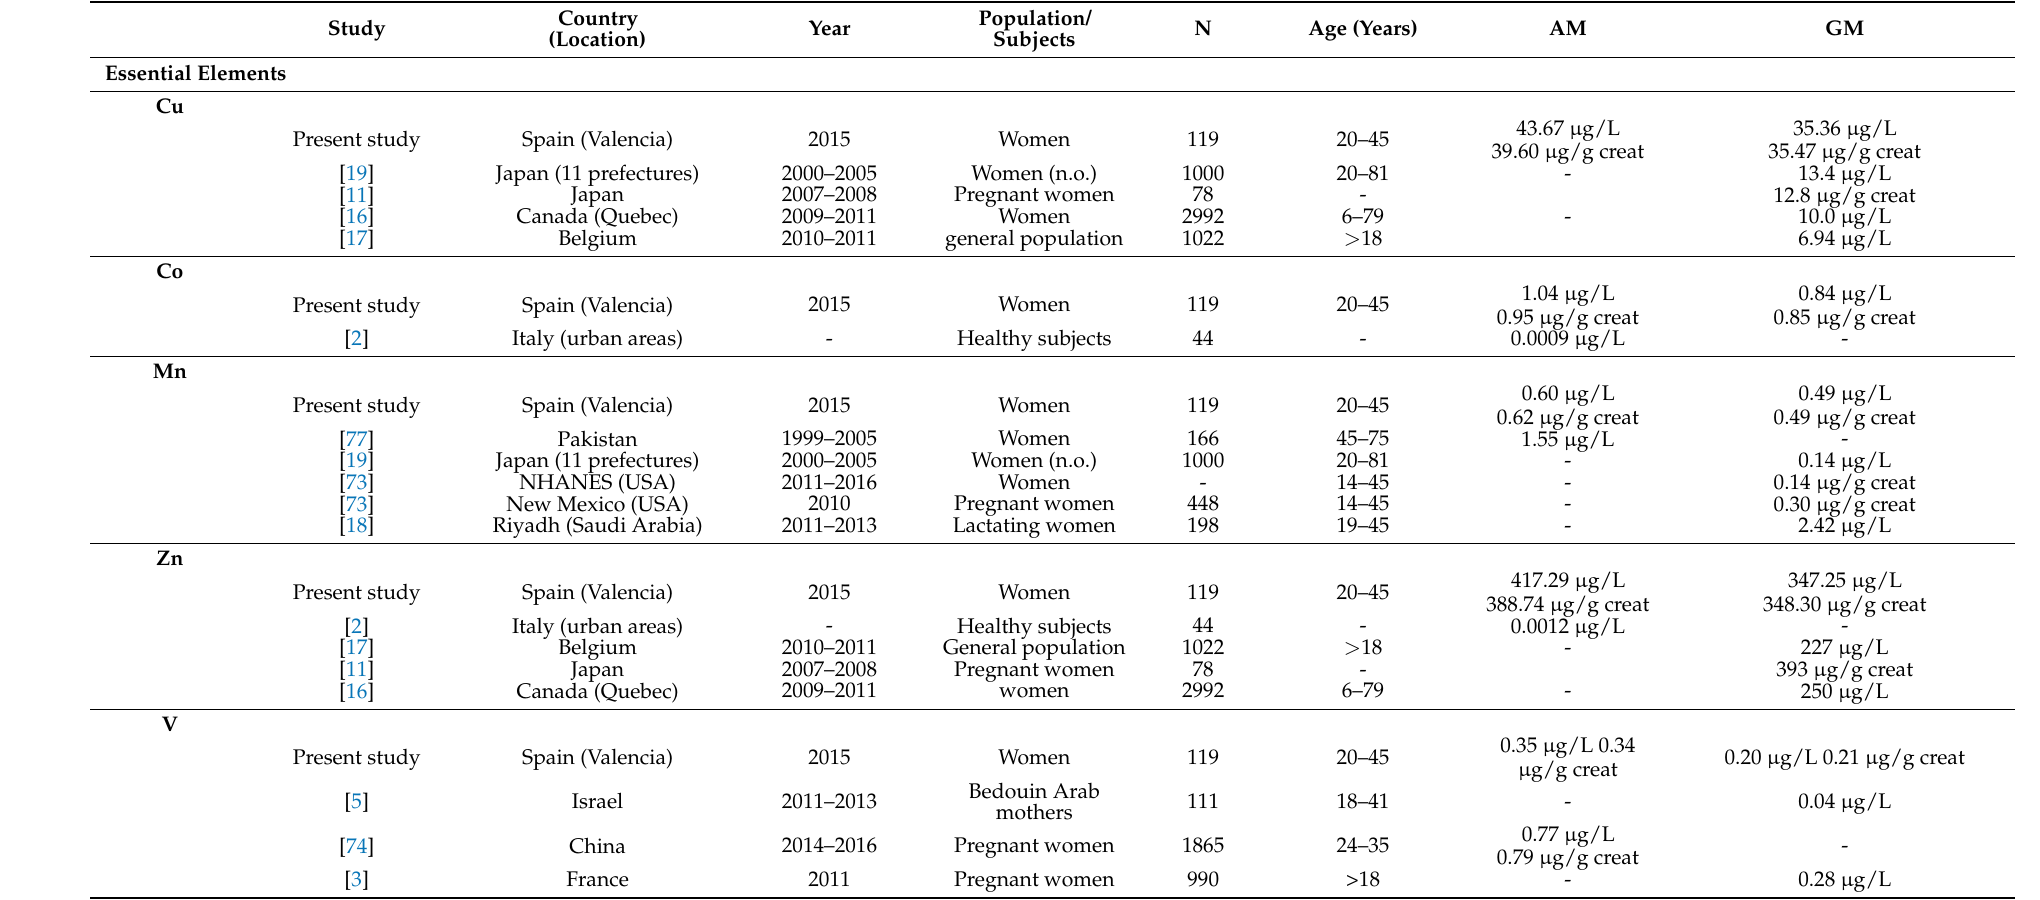
Table 5. Comparative data on levels of metals in women’s urine in other